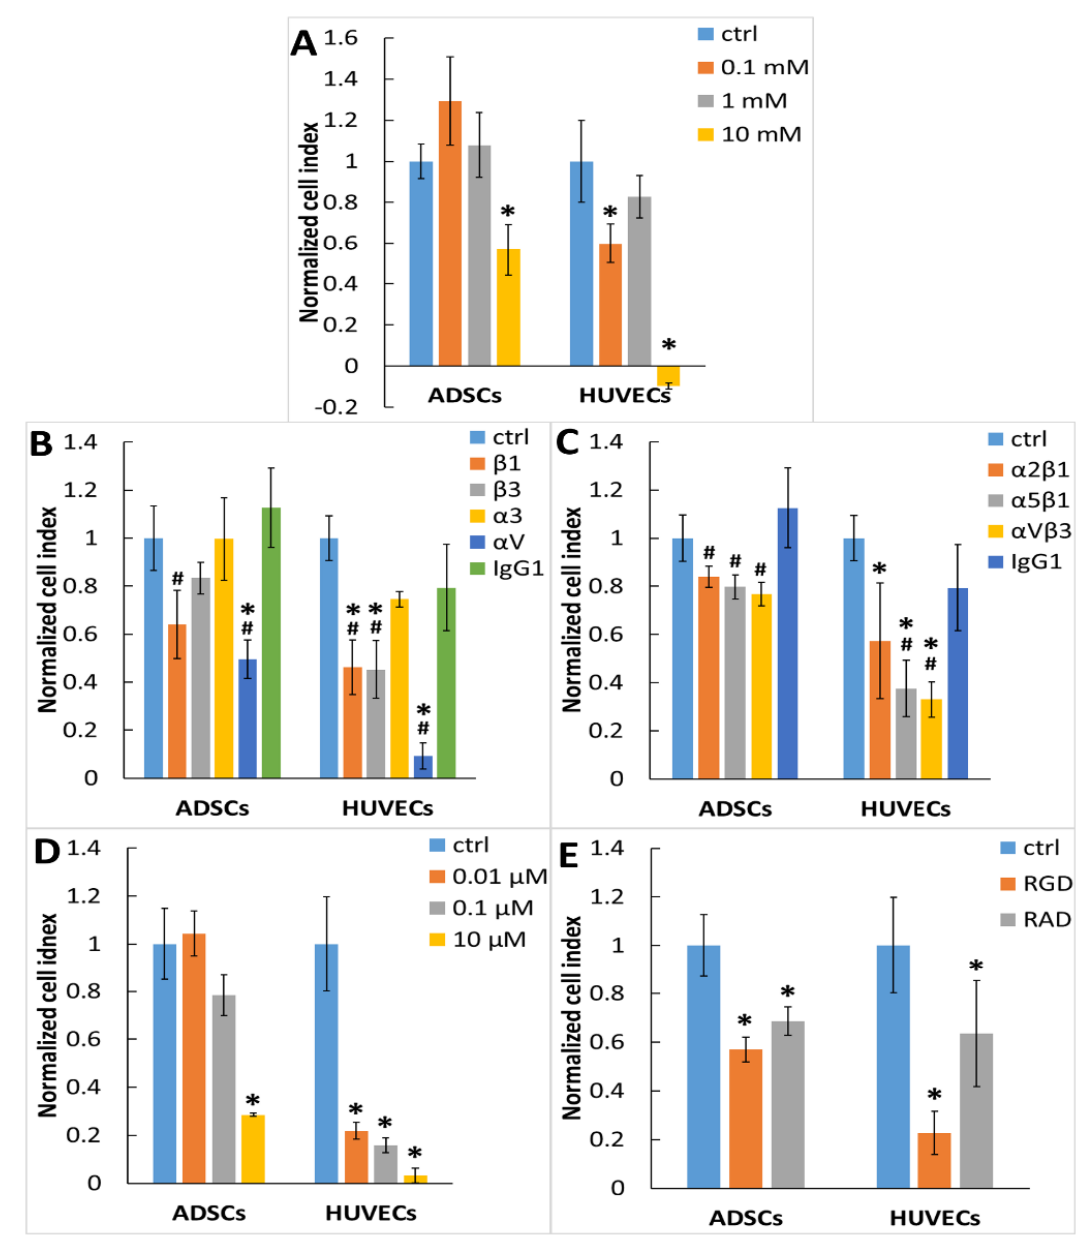
Figure 7. Role of integrins in the initial adhesion of ADSCs and HUVECs to substrate-immobilized Gal-3 (1 h after seeding). ( A ) The cells were seeded in a medium containing EDTA in concentrations ranging from 0.1 to 10 mM. ( B ) The cells were seeded in the medium containing antibodies against the β 1, β 3, α 3, and α V integrin subunits. The antibody against α V integrin subunit was used in a 1:25 dilution, and the other antibodies were used in a concentration of 20 µ g/mL. Nonspecific mouse IgG1 was used as an isotype control. ( C ) The cells were seeded in the medium containing antibodies against α 2 β 1, α 5 β 1, or α V β 3 integrin receptors. Nonspecific mouse IgG1 was used as an isotype control. Antibodies were used in a concentration of 20 µ g/mL. ( D ) The cells were seeded in a medium containing the α V β 1 inhibitor in concentrations ranging from 0.01 to 10 µ M. ( E ) The cells were seeded in a medium containing the GRGDSP peptide. The GRADSP peptide was used as a negative control. Both peptides were used in a concentration of 200 µ M. Before cell seeding, the wells were coated with 1 µ M Gal-3 and blocked with 0.5% w/v BSA. The cell index values were normalized to the untreated sample in a pure medium without any additive (ctrl). Mean ± SD from 3 wells. Holm-Sidak test, p ≤ 0.05. The samples were statistically compared within the group of the indicated cell type. * Statistically significant difference in comparison with the control cells (ctrl). # Statistically significant difference in comparison with the cells incubated with the isotype control